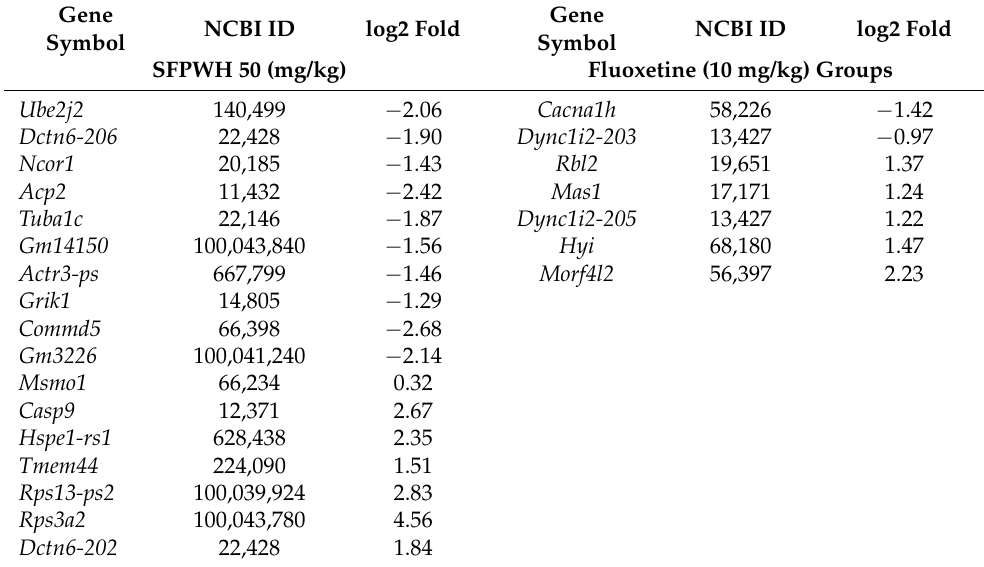
Figure 4. Transcriptome differences detected between the mean of the control group and treatment groups. ( a ). Hierarchical cluster analysis of gene expression based on log-ratio FPKM data for the mean of transcripts replicates illustrating the impact of the administration of safflower hot water extract and fluoxetine treatment in comparison to control where red indicates upregulation pattern while blue color indicates downregulation pattern. ( b ). Heatmap showing significantly different gene expression patterns (log2 fold). ( c ). The bar charts for the gene ontology enrichment analysis show the top pathways for the significant enrichment genes for all groups. p -value cutoff (FDR) 0.05. Table 2. List of the significant differential expressed genes of safflower hot water extract SFPWH (50 mg/kg) and fluoxetine-treated group compared to the control group.